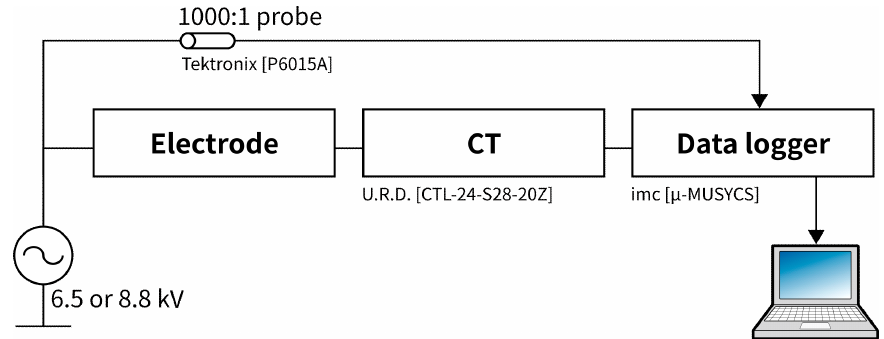
Figure 2. Schematic diagram of experimental